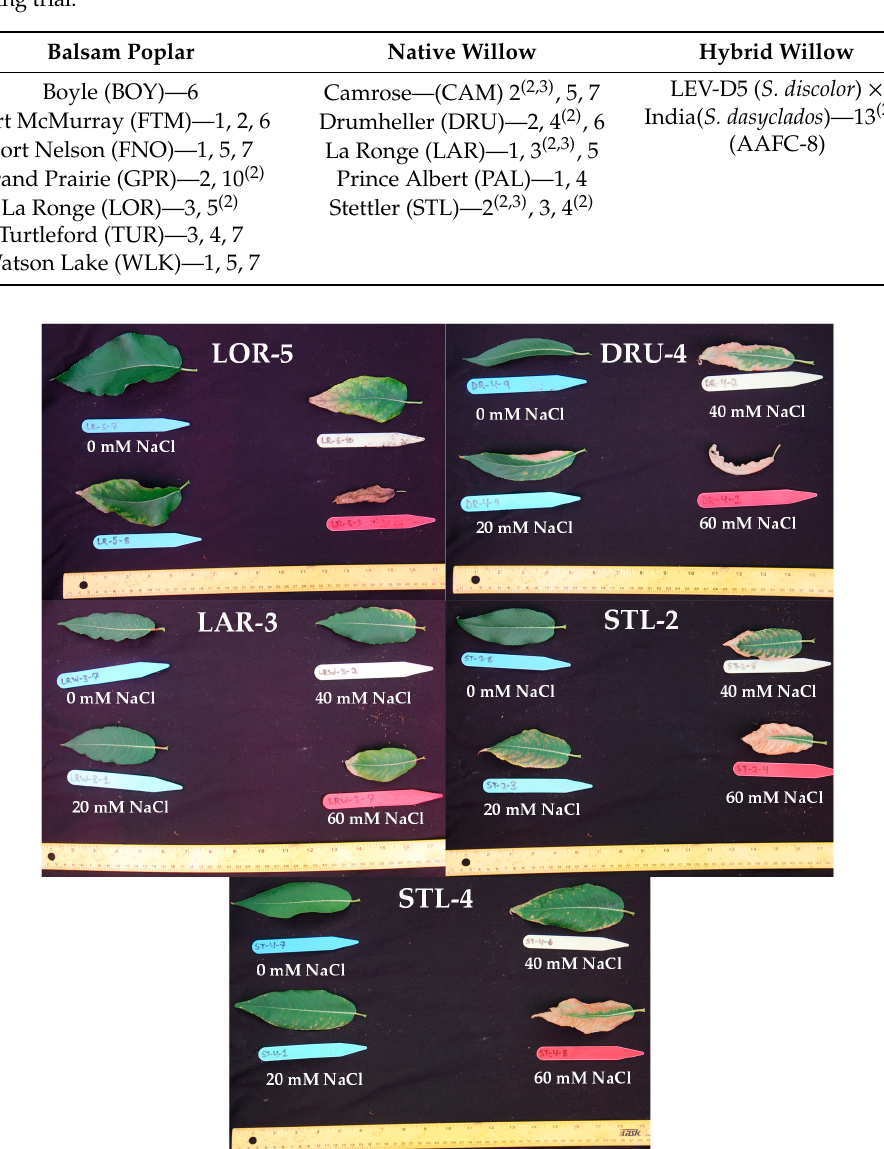
Table A1. Balsam poplar, native and hybrid willow genotypes used in salinity trials. Superscripts indicate genotypes that were grown in experiments 2 and 3, no superscript indicates use in only the first Table A3. Fracking wastewater composition used in the greenhouse study. screening trial.